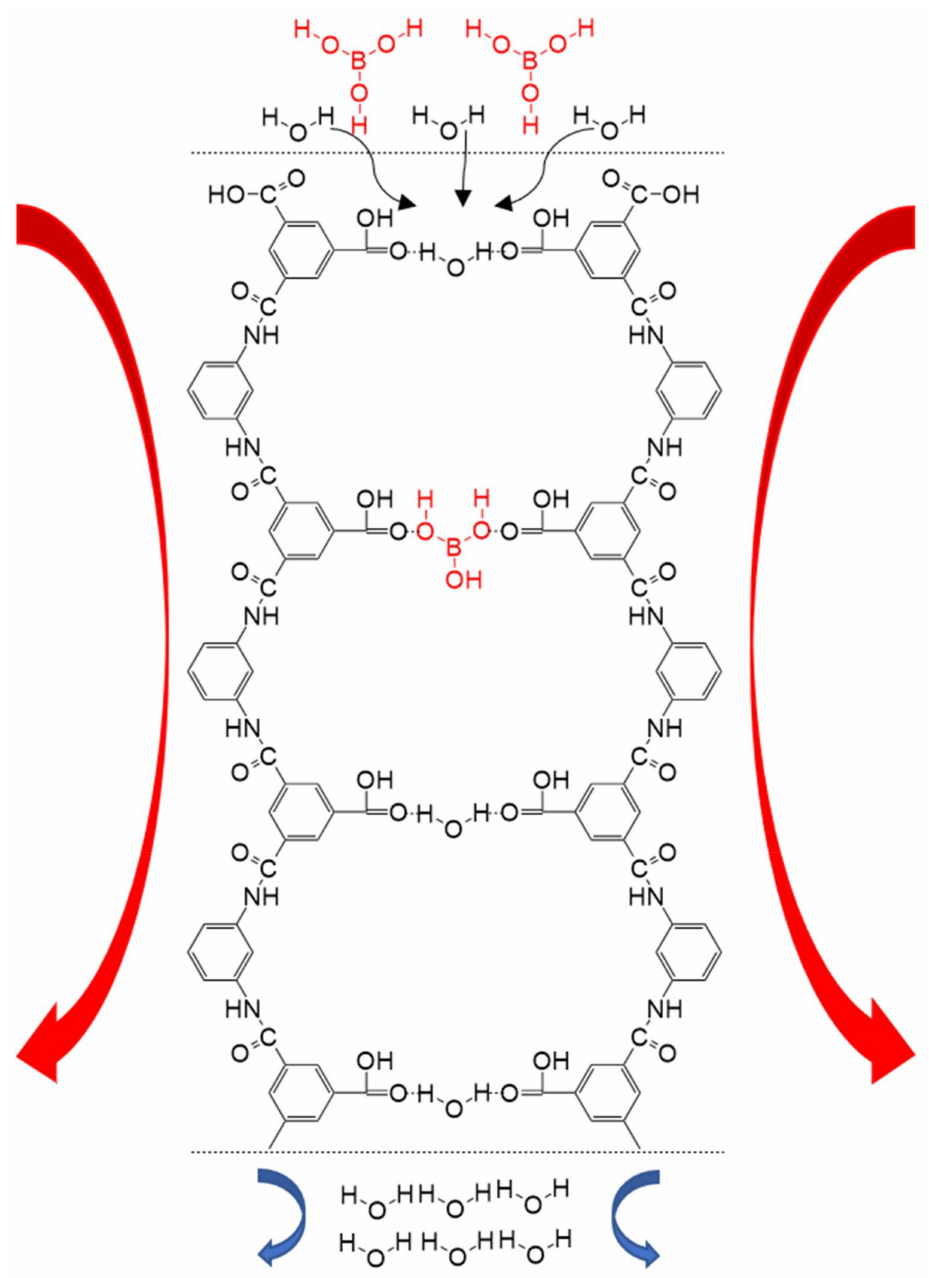
Figure 4. Transport of boron through the RO